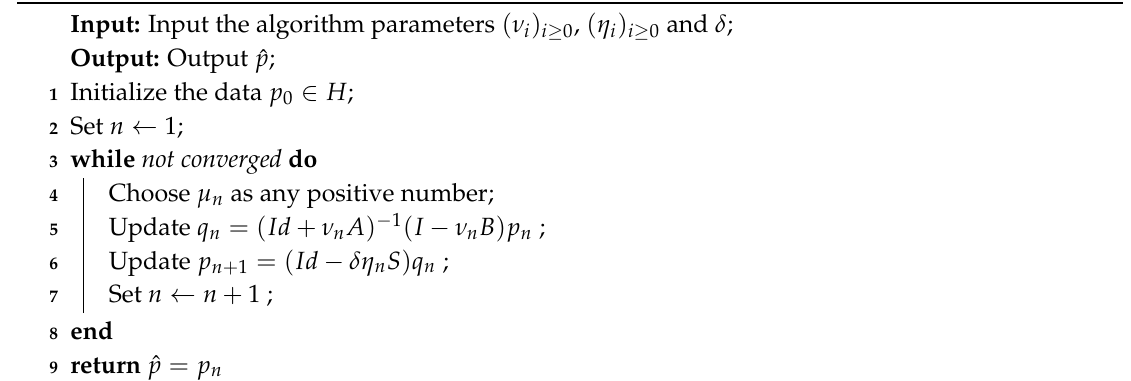
Algorithm 2: The hybrid forward–backward algorithm without the inertial term